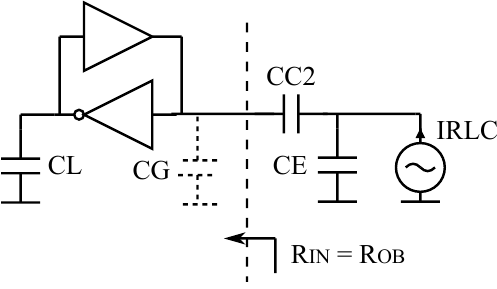
Figure 15. Equivalent model in read-out mode.